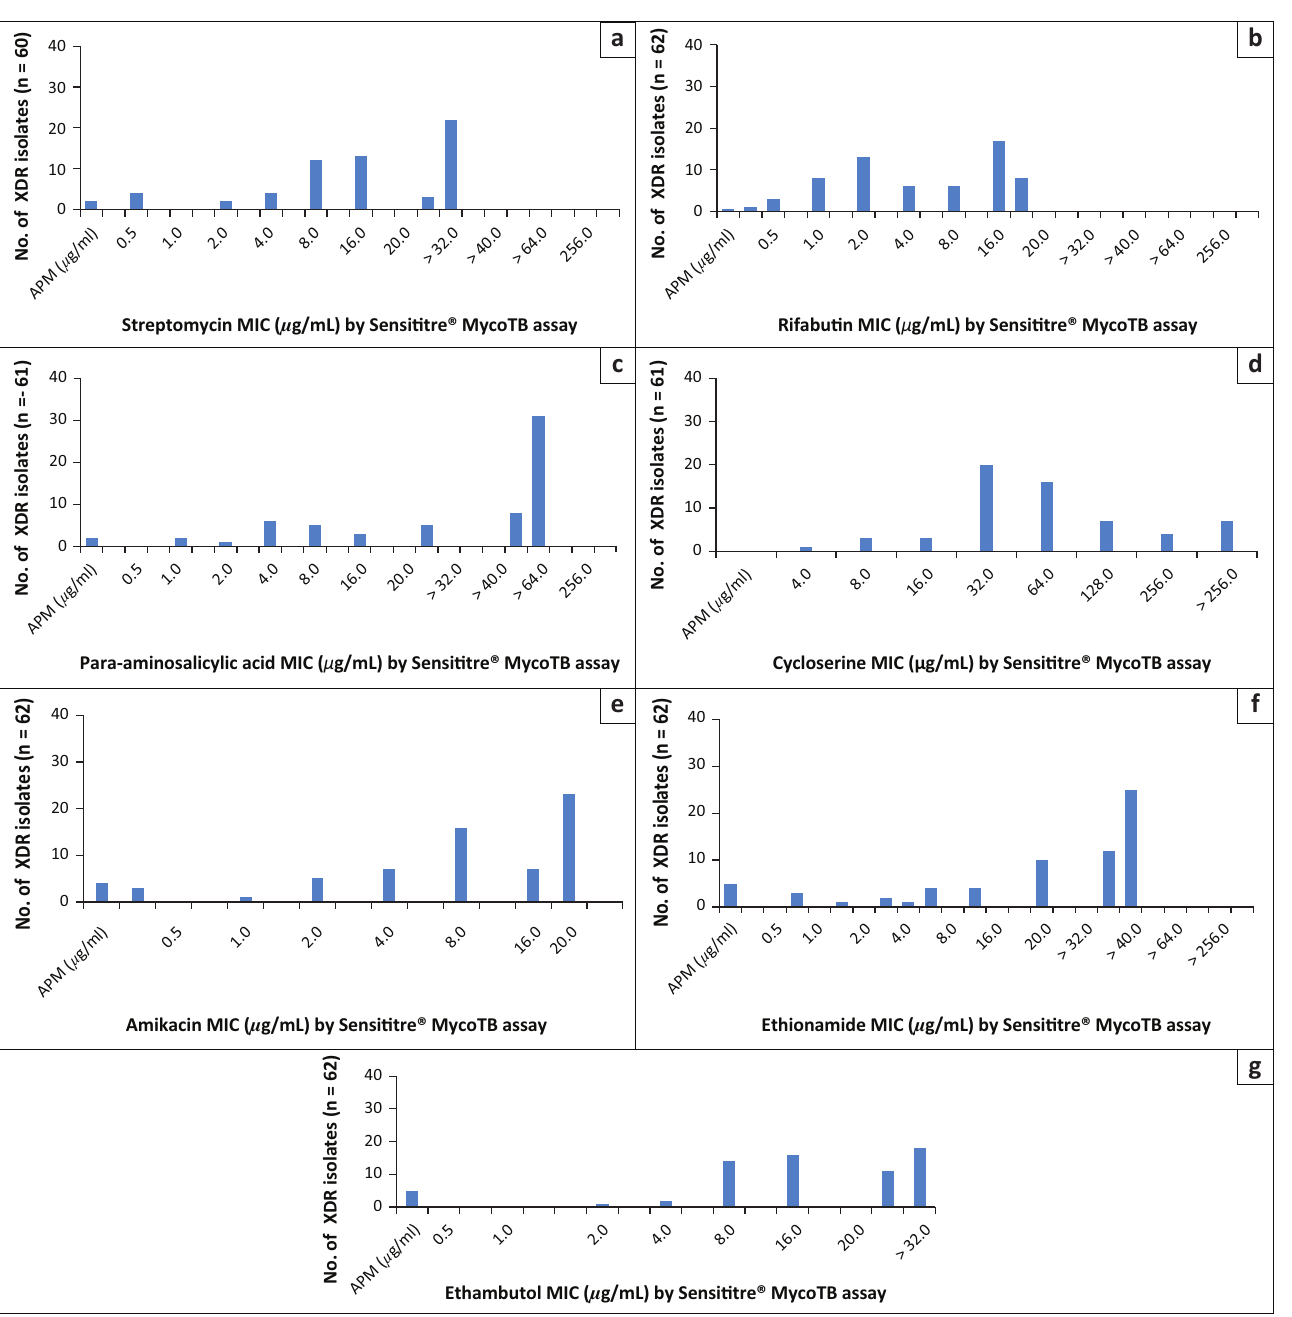
FIGURE 4: Distribution of minimum inhibitory concentrations ( µ g/mL) for additional first- and second-line antibiotics using the Sensititre plate method for clinical, extensively drug-resistant tuberculosis isolates, Inkosi Albert Luthuli Central Hospital, Durban, South Africa, January 2014 – June 2015. (a) STR (60 isolates), (b) RFB (62 isolates), (c) PAS (61 isolates), (d) CYC (61 isolates), (e) AMI (62 isolates), (f) ETH (62 isolates) and (g) EMB (62